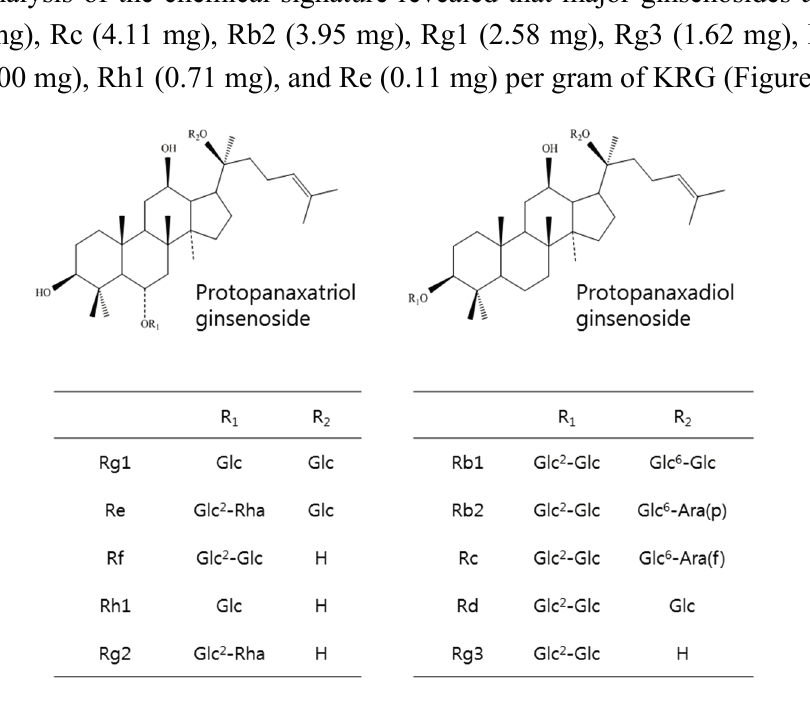
Figure 6. Chemical structures of ginsenosides in